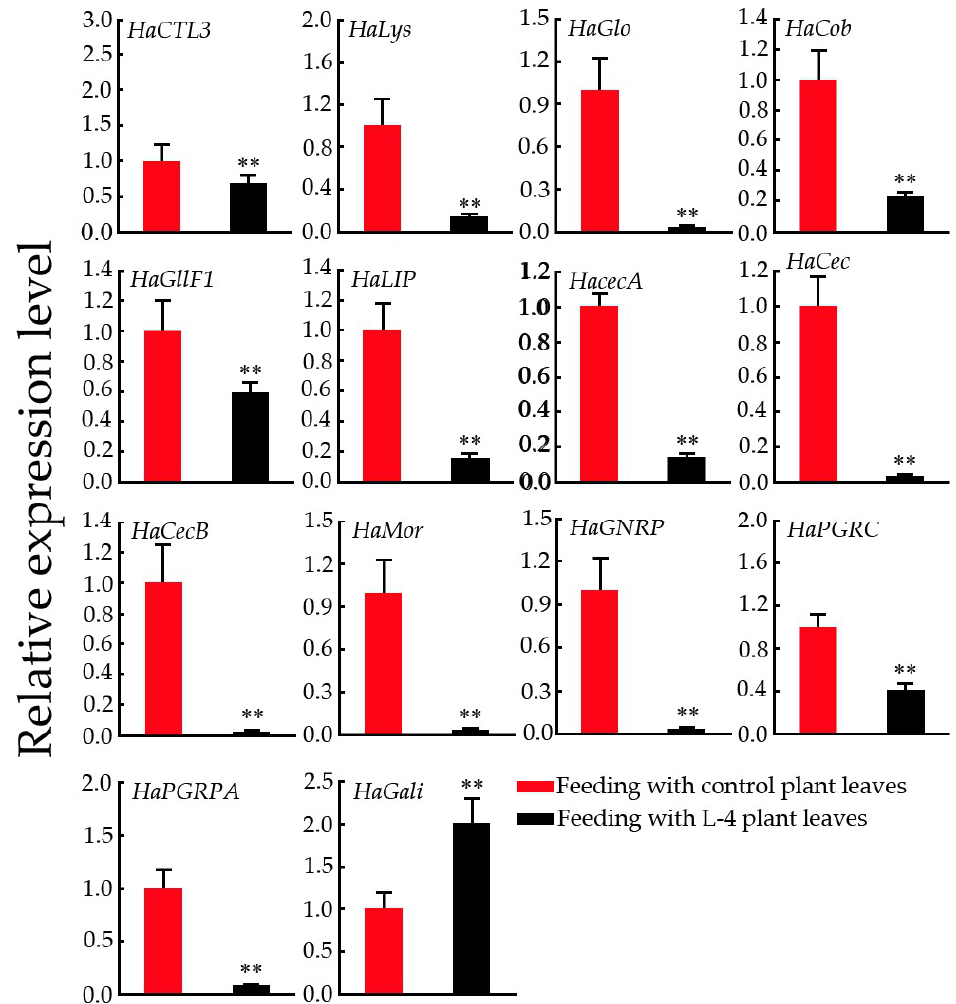
Figure 8. Expression patterns of H. armigera immunity-related genes in H. armigera fed wild-type plants leaves (red column) and transgenic Arabidopsis plant leaves heterologously expressing GsMYB15 (black column). H. armigera actin (HaActin) was used as an internal standard to normalize the templates. The relative mRNA levels are represented as the mean ± SD ( n = 3). Statistically significant differences were assessed using Student’s t -test (** p < 0.01).